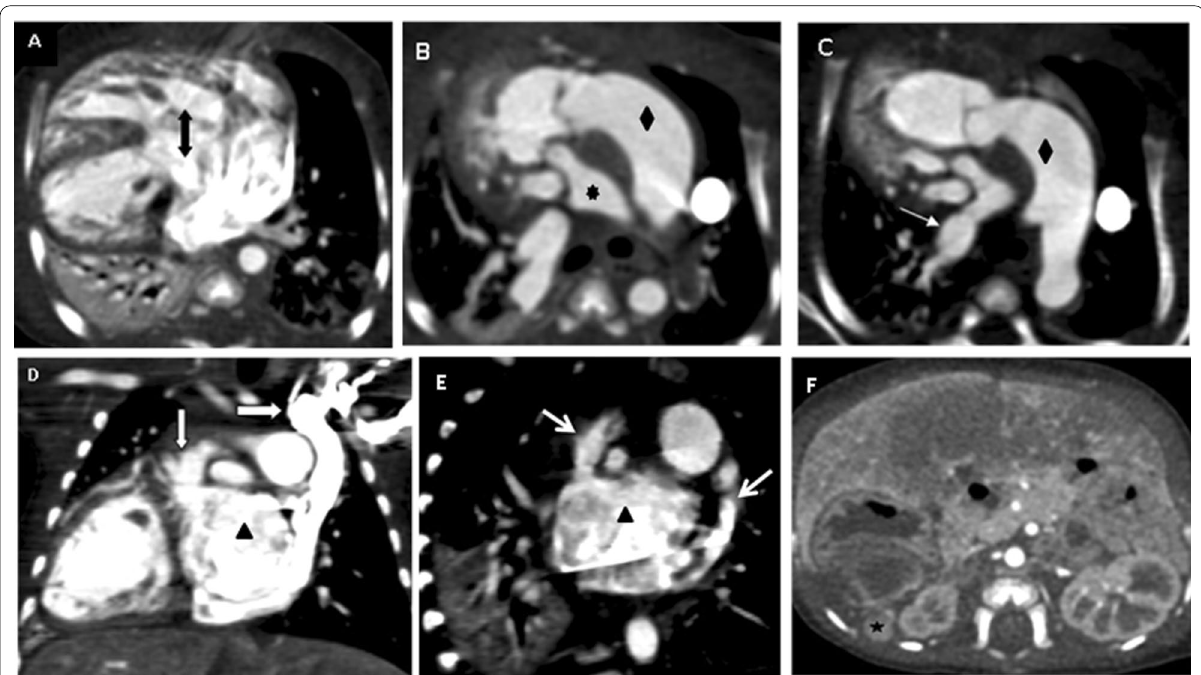
Fig. 8 A 35-day-old male with situs inversus totalis A dextrocardia with common atrium, common AV canal (double head arrow). B , C DORV with aorta (diamond) and MPA (*) arising from anterior RV with severe pulmonary stenosis, kink of origin of RPA (arrow in C ) with post stenotic dilatation. D , E Coronal and sagittal MPR showing common atrium (triangle) receiving Lt SVC and persistent Rt SVC (arrows). F Axial images of upper abdomen show midline liver, Rt small splenule (* in F ) and Rt sided